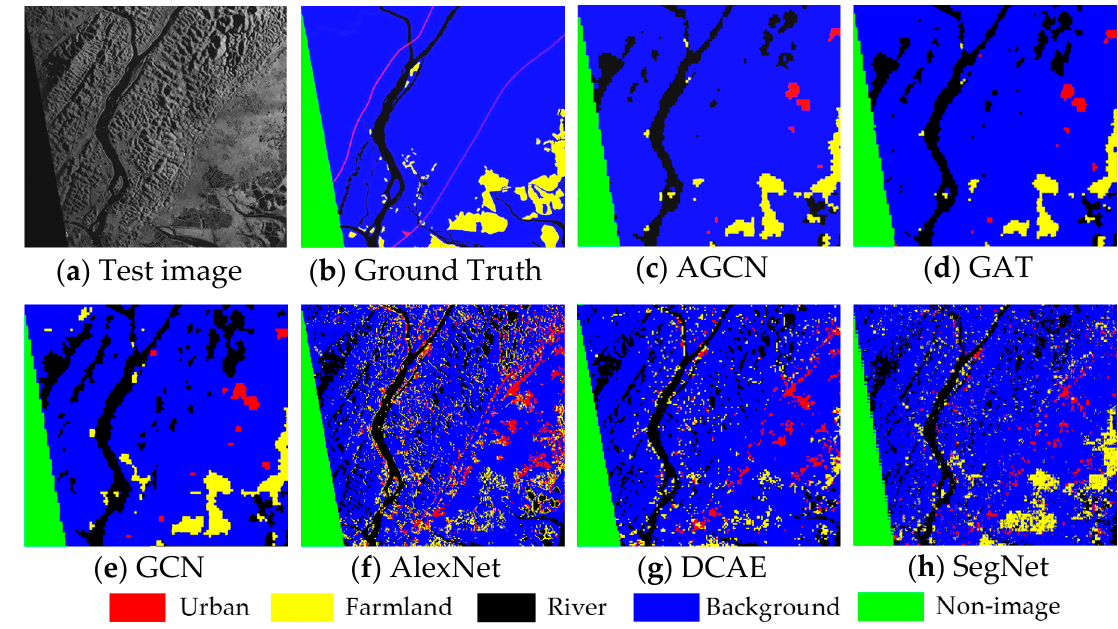
Figure 4. Segmentation results of six models on the Fangchenggang dataset. ( a ) Input image; ( b ) ground truth; ( c ) AGCN; ( d ) GAT; ( e ) GCN; ( f ) AlexNet; ( g ) DCAE; ( h ) SegNet.